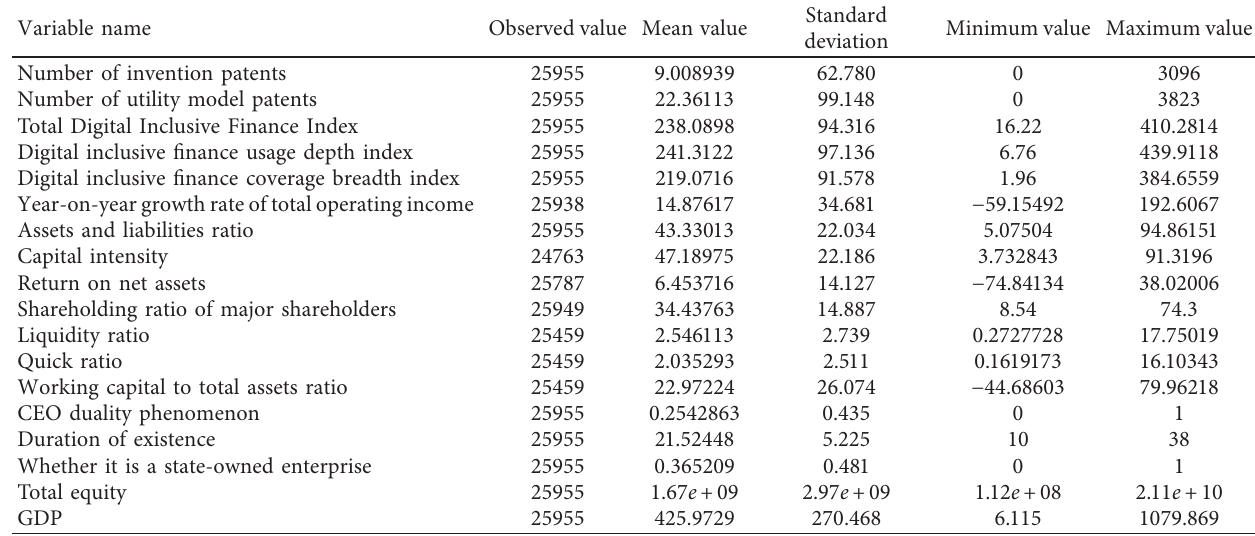
Table 4: Descriptive statistics.